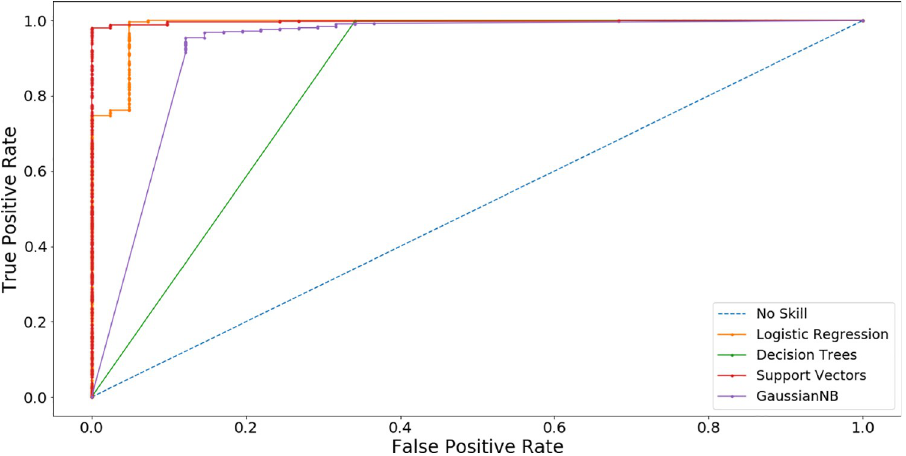
Fig 7. Receiver-operating characteristic curve by machine learning model. The closer the ROC curve is to the upper left corner, the higher the overall accuracy of the test.